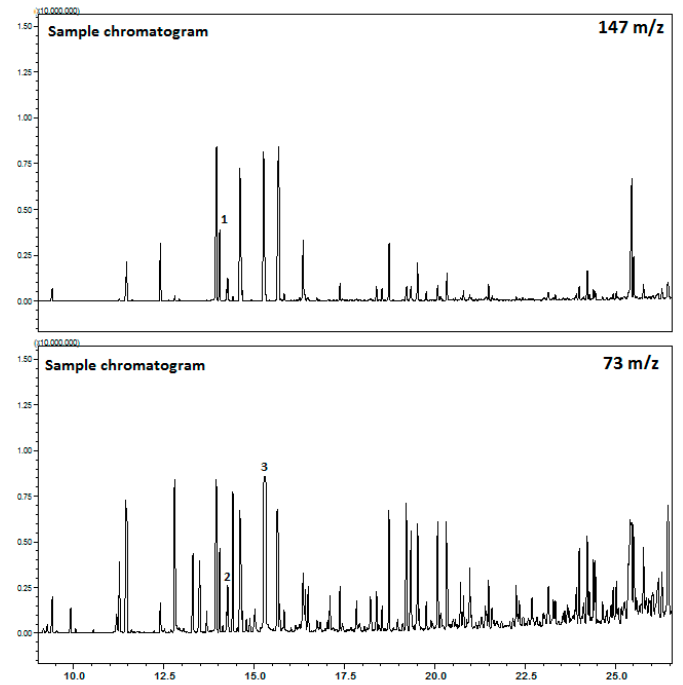
Figure 3. GC/MS chromatograms of standards (1-lactic, 2-glycolic, and 3-malic acids) and organic acid derivatives extracted from Saffron stigmas.